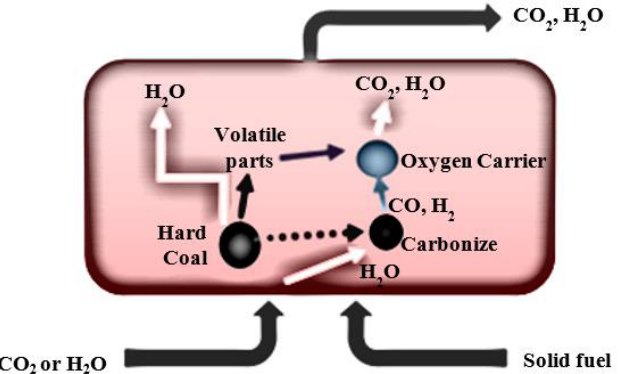
Figure 2. The scheme of oxygen release in the fuel reactor in the iG-CLC process.